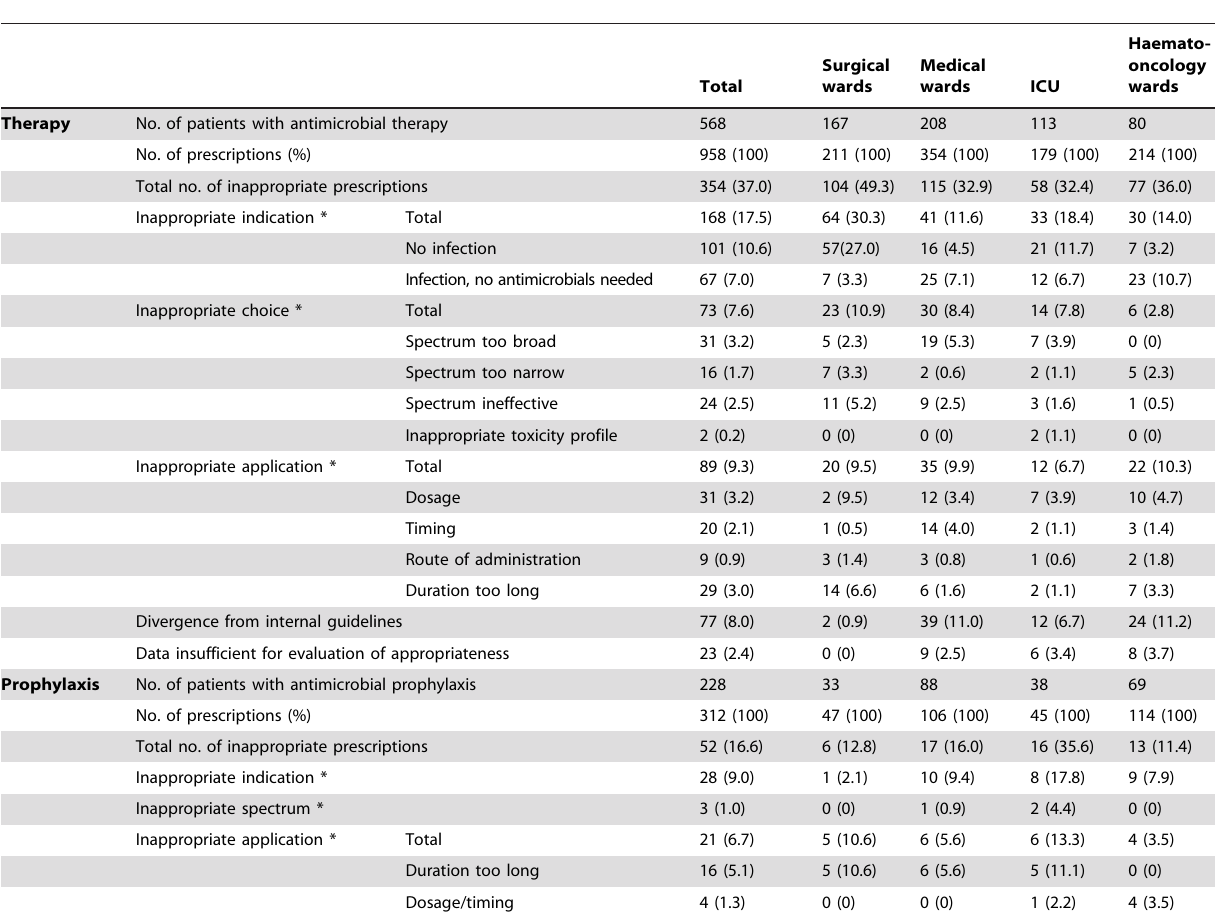
Table 4. Evaluation of the appropriateness of antimicrobial treatment and prophylaxis.